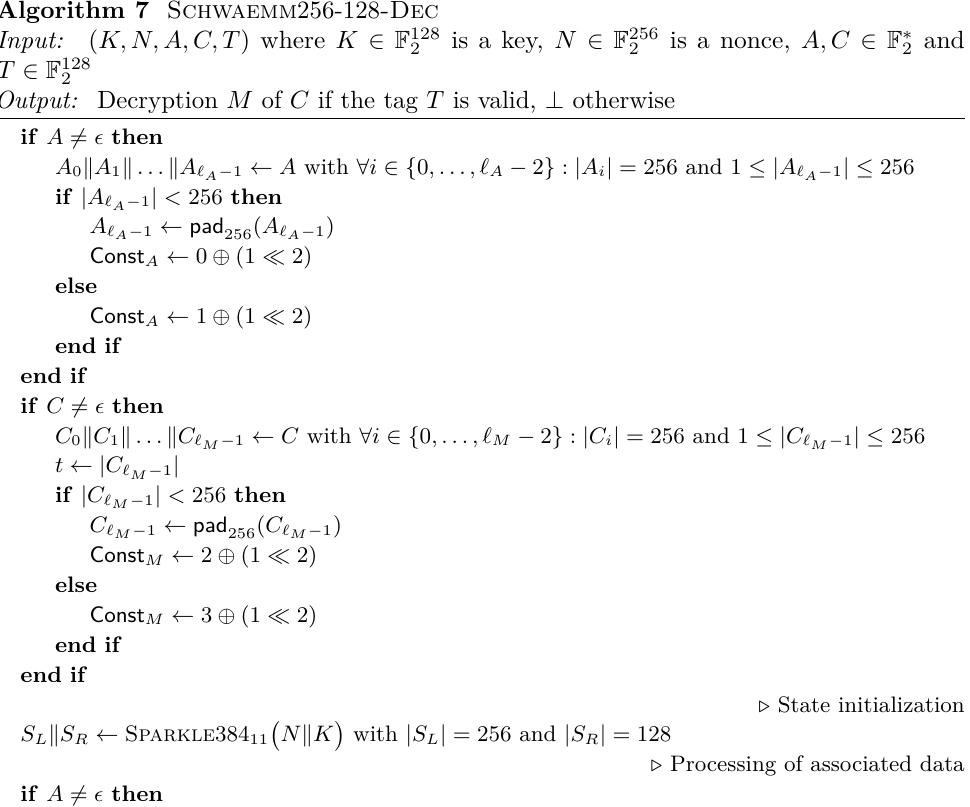
Algorithm 7 Schwaemm 256-128